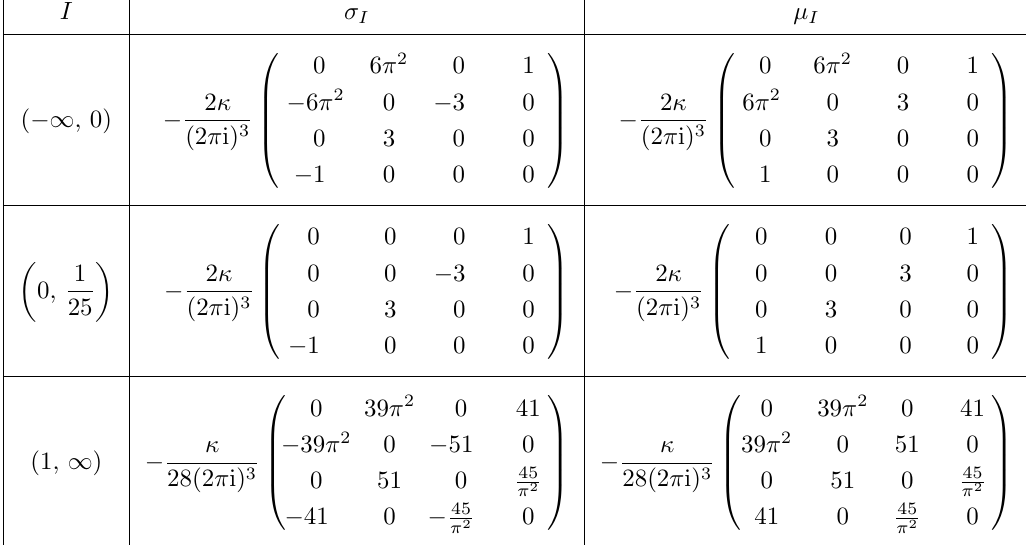
Table 3 . The matrices (cid:27) I and (cid:22) I for the intervals of the real axis that contain the three attractor